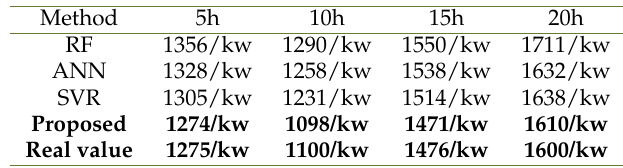
Table 1. Comparison with different forecasting methods